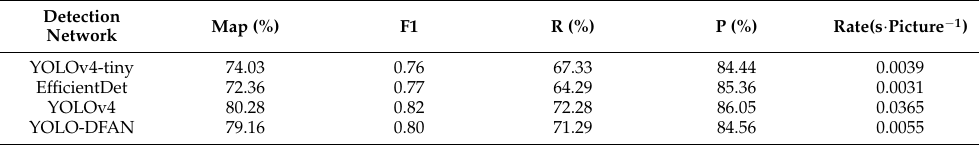
Table 1. Belt detection effects of different networks.